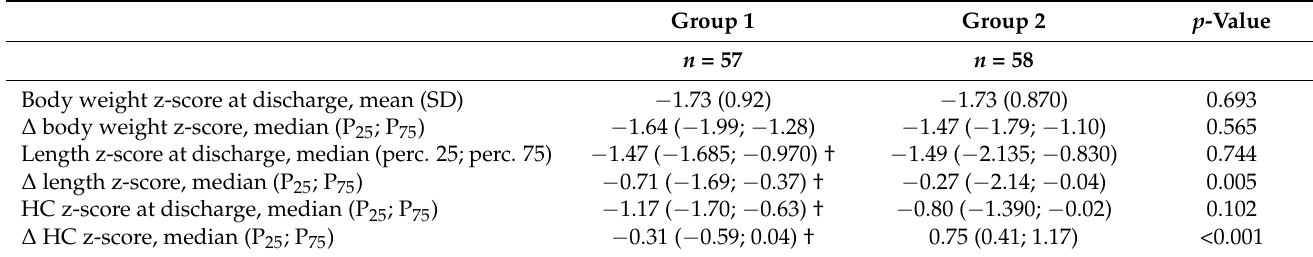
Table 4. Body weight, length, and head circumference ∆ z-scores from birth to discharge ( n = 115). Group 1—fortified HM based on its assumed macronutrient content. Group 2—fortified HM based on its measured macronutrient